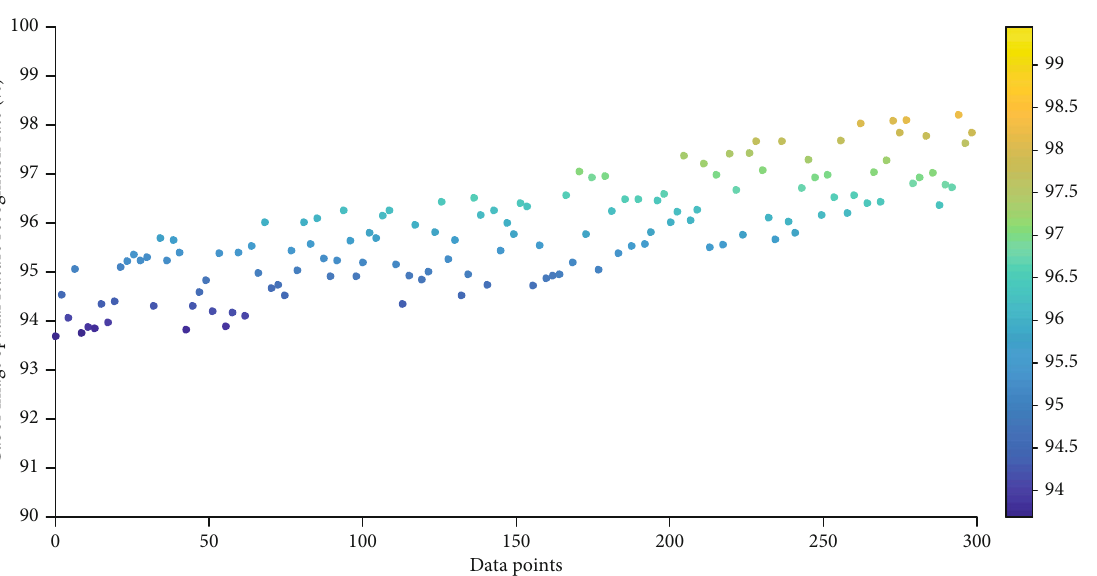
Figure 8: Gabor image spatial feature recognition rate two-dimensional scatter point